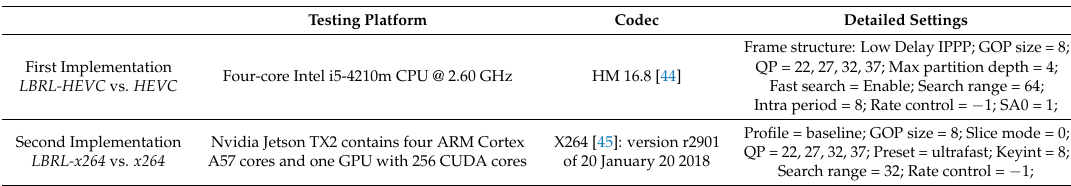
Table 1. Experimental configuration of two implementations.